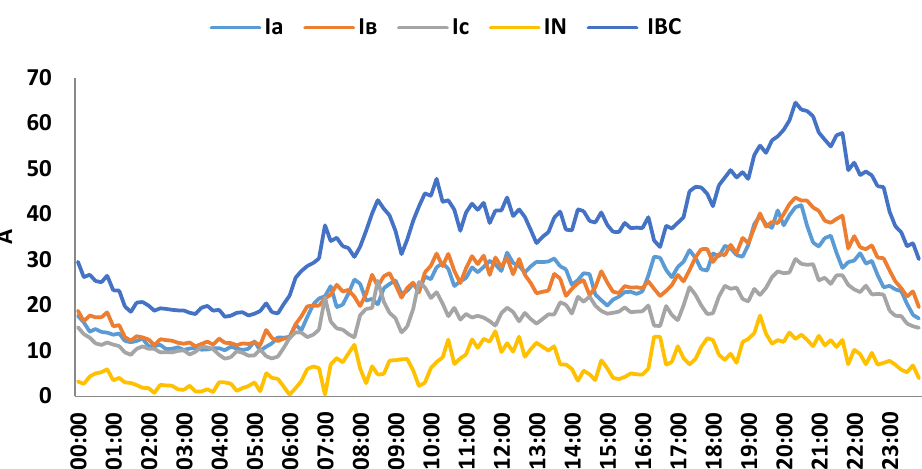
Fig. A6 – Change of the phase currents on input of the apartment